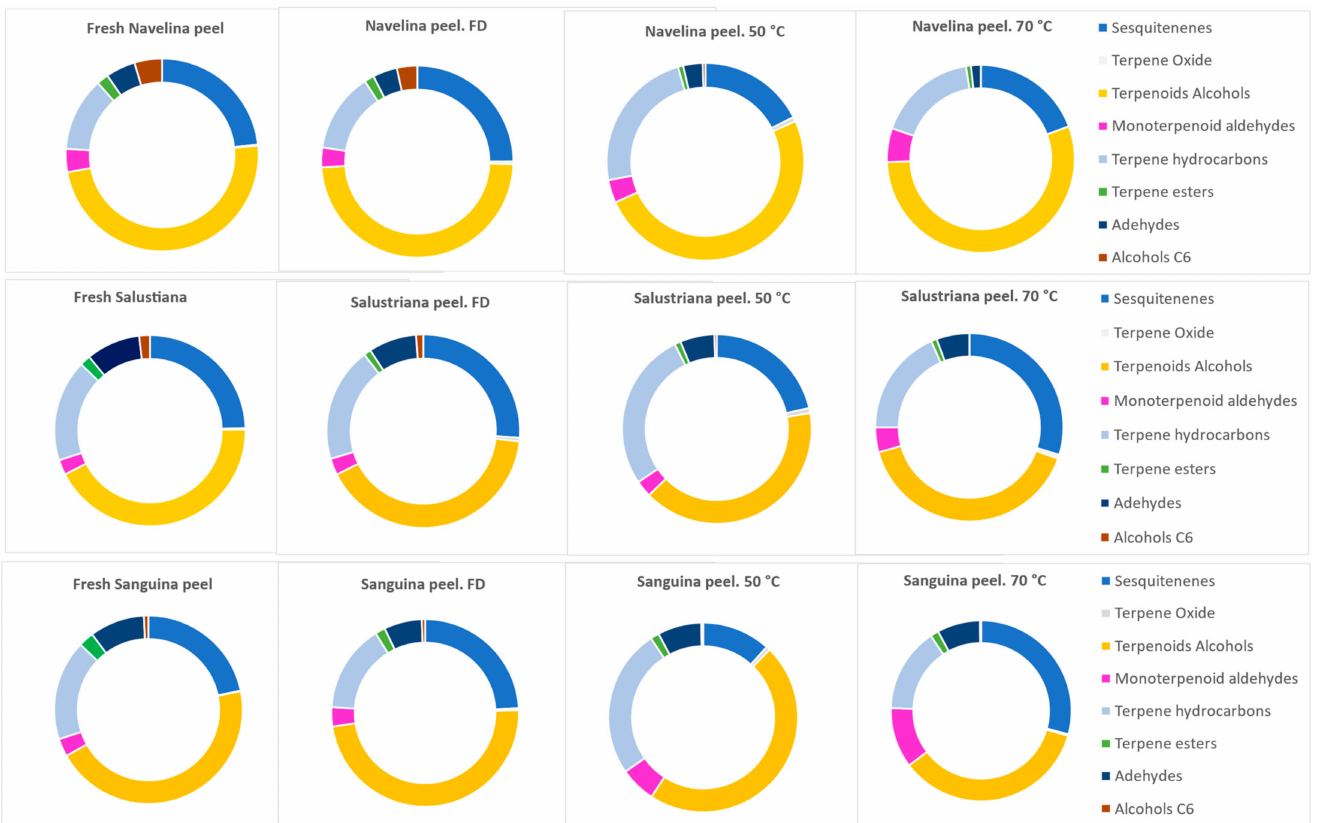
Figure 1. Percentage (%) of every chemical family of VOCs respective to the total of volatile compounds, for every orange variety (Navelina, Salustriana, and Sanguina) and for every treatment: fresh, freeze-dried (FD), and oven-dried (50 ◦ C, 70 ◦